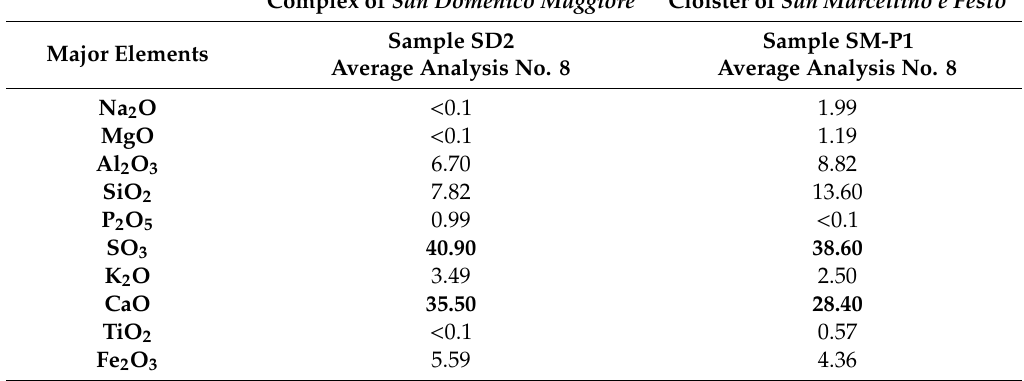
Table 3. Average concentrations of major elements expressed in oxides (wt%) in the black crust of